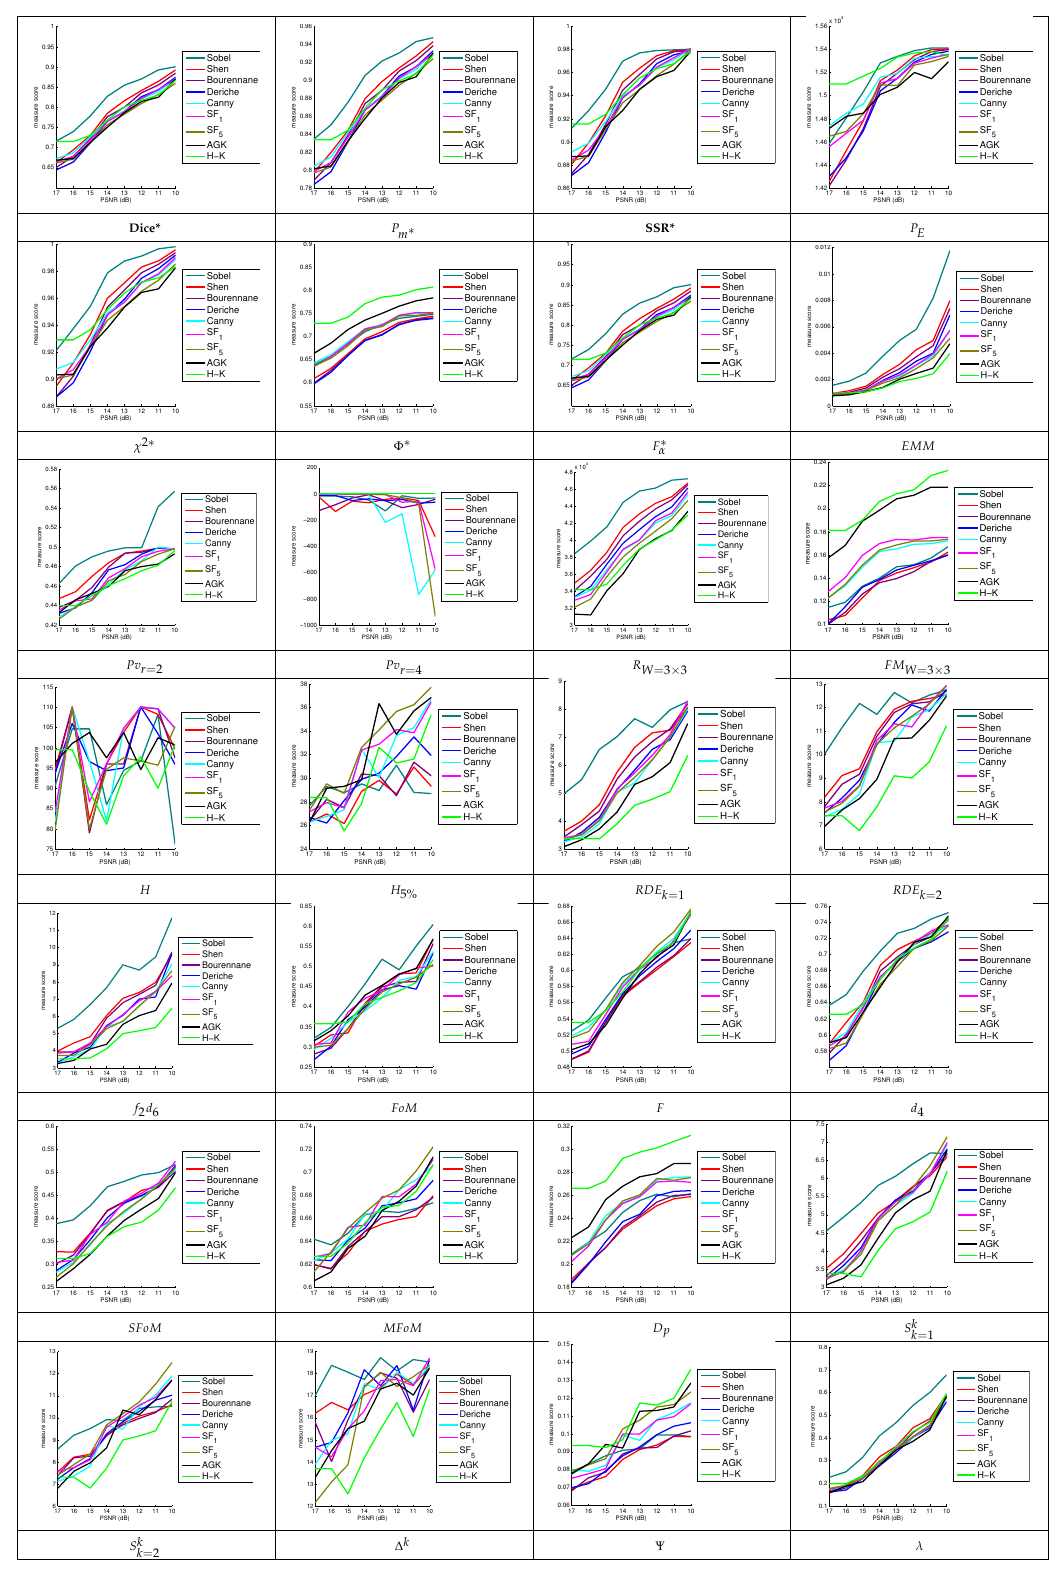
Figure 18. Image 109: Comparison of edge detection evaluation evolution as a function of PSNR